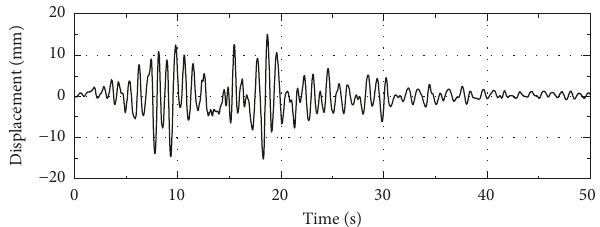
Figure 18: Displacement response curve of intensity 7 fortification of synthesized (longitudinal input).